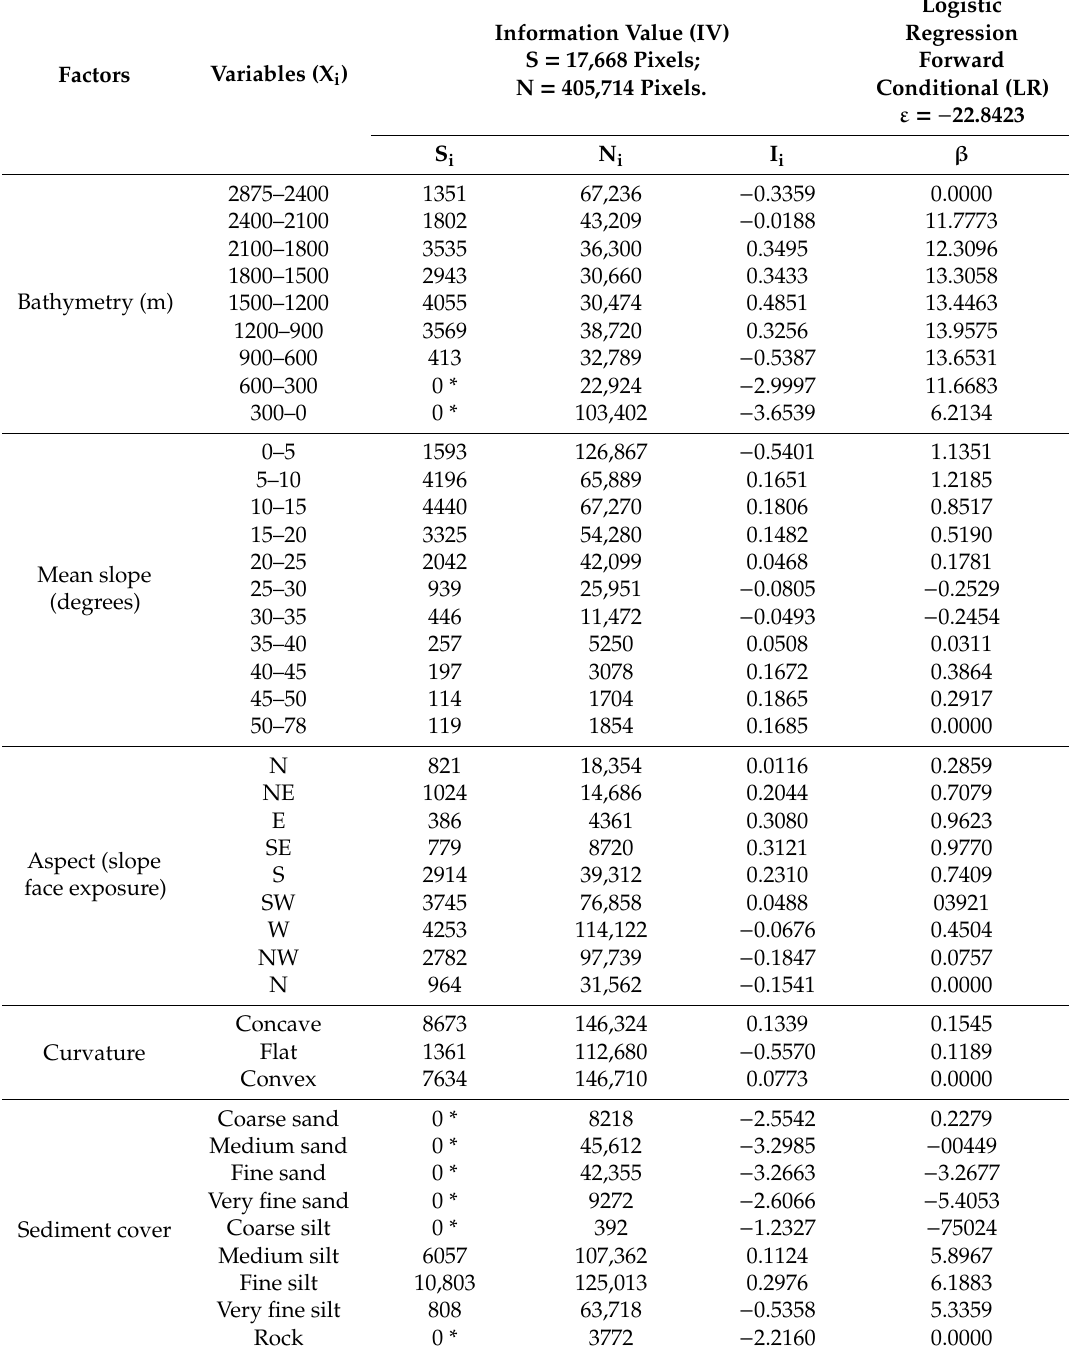
Table 2. Information value (I i ) and logistic regression (constant ε and β values) results for each one of the